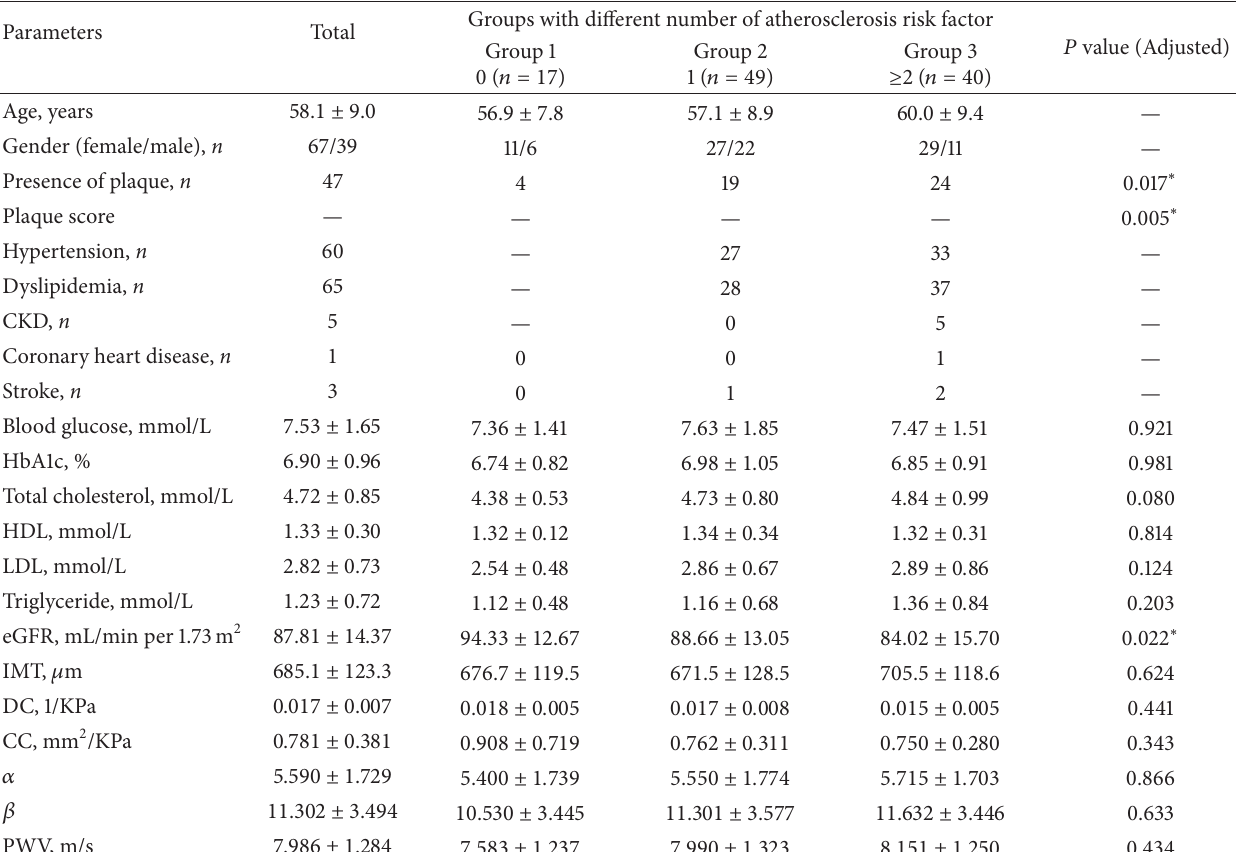
Table 1: Demographic and ultrasonographic characteristics in Chinese subjects with type 2 diabetes with different numbers of atherosclerosis risk factors.